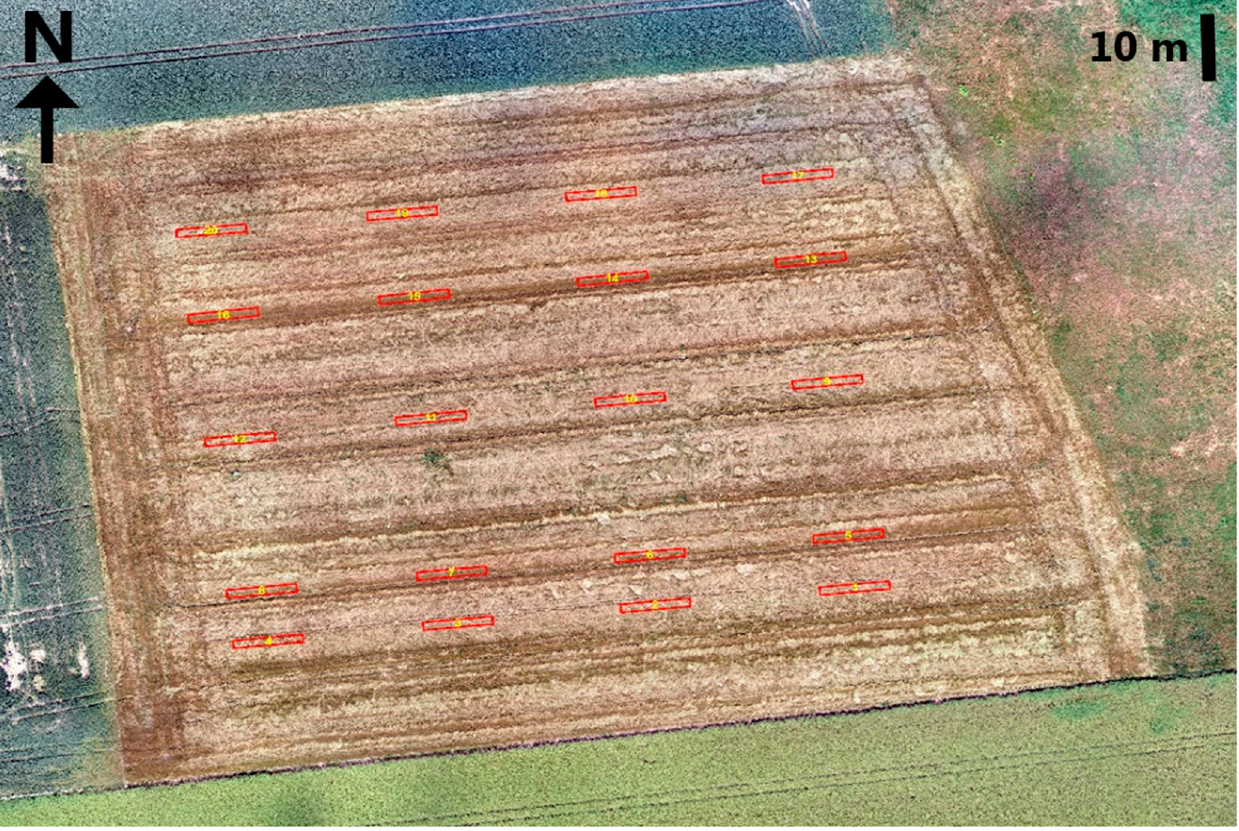
Figure 2. UAV image of the fi eld and plots from 24 June 2020. The red markings show the plots where seed yields were harvested , University of Copenhagen in Taastrup (55°40 ′ 8.16 ′ ’ N; 12°18 ′ 18.82 ′ ’